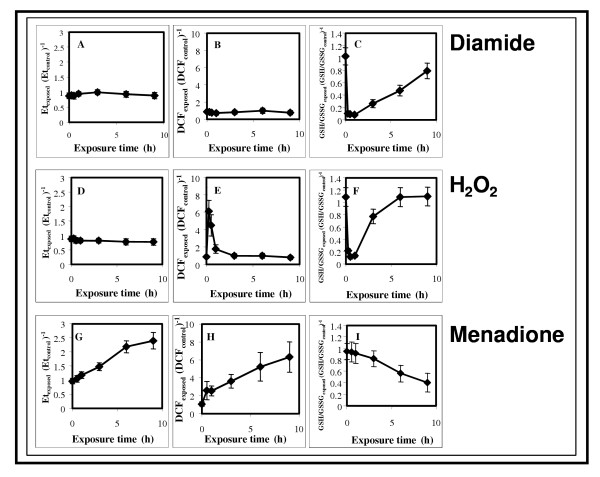
Time-course of physiological changes under diamide, H2O2 and menadione stress. Intracellular superoxide (Parts A, D and G), peroxide (Parts B, E and H) concentrations and GSH/GSSG values (Parts C, F and I) recorded under stress were factored with their counterparts found in untreated control cultures {Etexposed (Etcontrol)-1; DCFexposed (DCFcontrol-1); GSH/GSSGexposed (GSH/GSSGcontrol)-1}. Intracellular superoxide and peroxide levels were characterized by specific Et (ethidium) and DCF (dichlorofluorescein) productions, respectively, in both stress-exposed and control cultures (Additional file 1:Supplement1 for physiological changes).